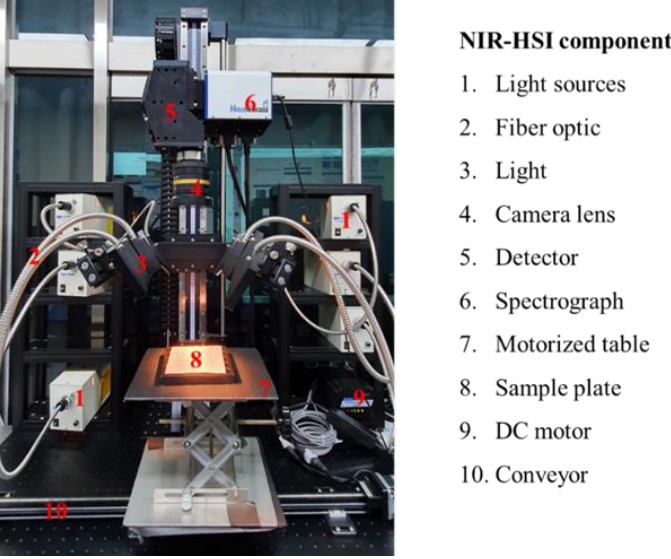
Figure 1. Laboratory-based scan of near-infrared (NIR) hyperspectral imaging system. Table 1. List of examined black rice varieties of two years harvesting time.